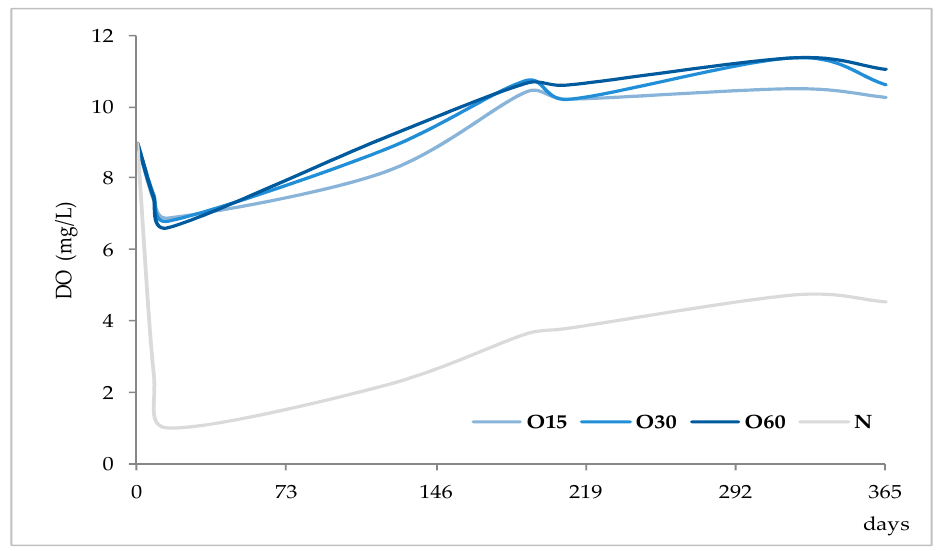
Figure 4. Average dissolved oxygen content in the WSs during the ageing period (measurement made on a water-based basis).